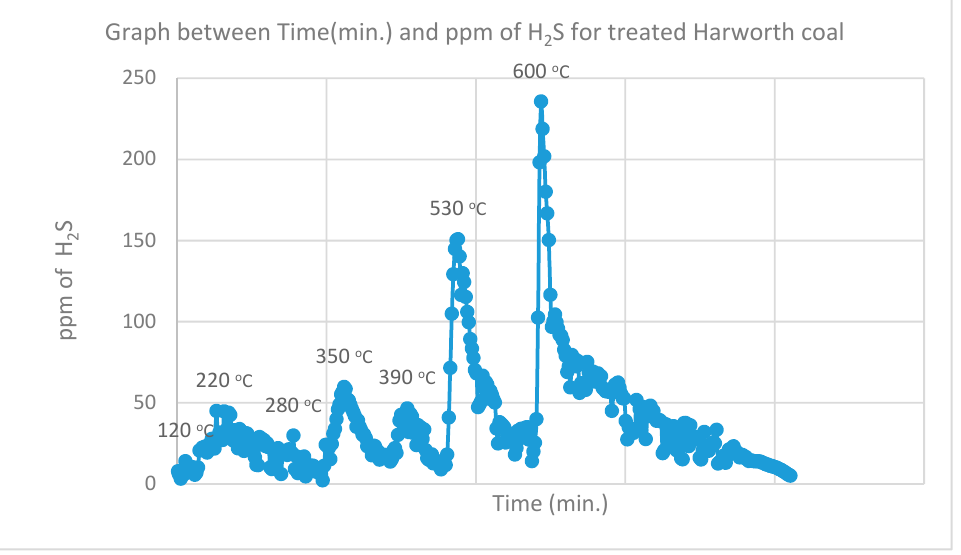
Figure 3. TPR of treated harworth coal.